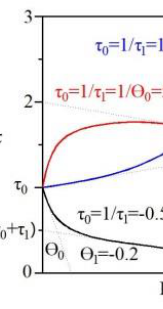
Figure 1. Physical meaning of hardening parameters.